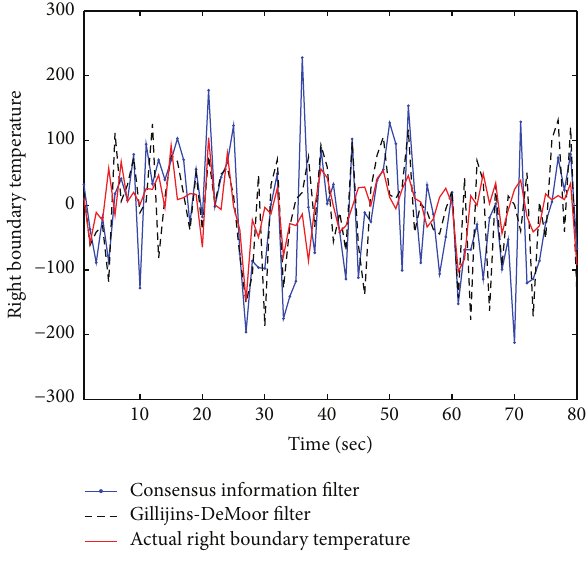
Figure 6: The right boundary conditions.